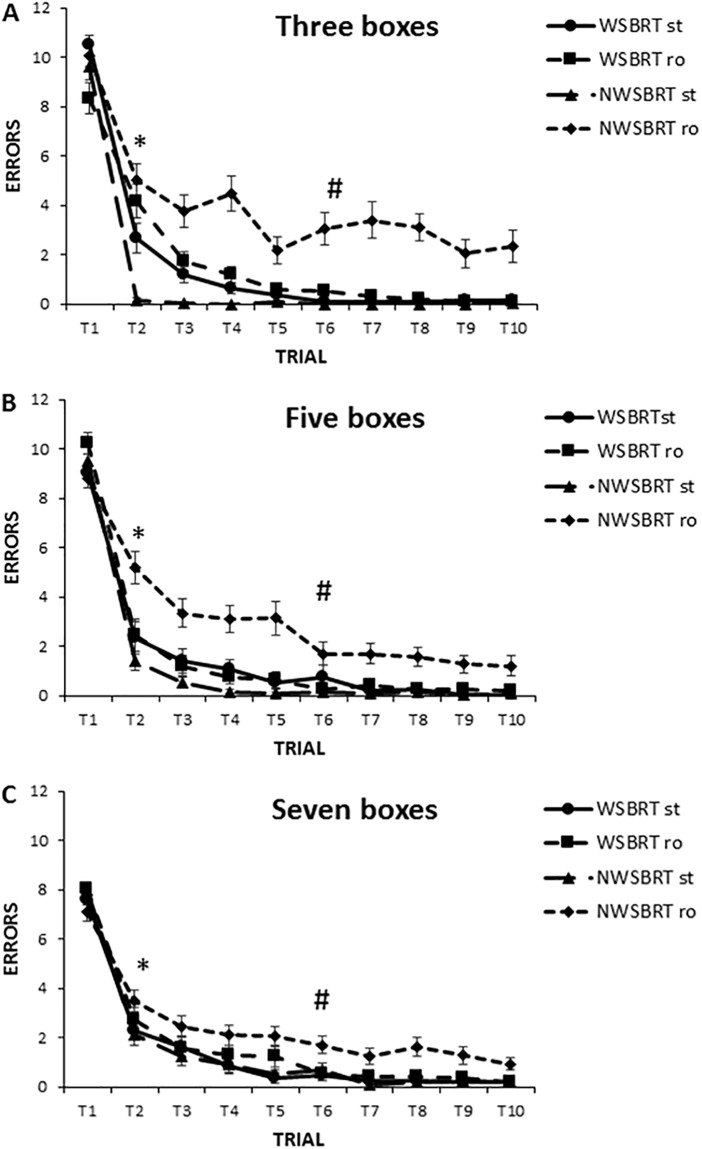
Number of errors in WSBRT and NWSBRT (stable and rotated conditions).A, B and C for three, five and seven boxes conditions, respectively. Note that participants made more errors in the rotated NWSBRT (#). This clearly shows that the rotation of the environment increase the difficulty of the task. The number of errors decreased on trial 2 (*). ST = stable; RO = rotated. Mean±SEM.